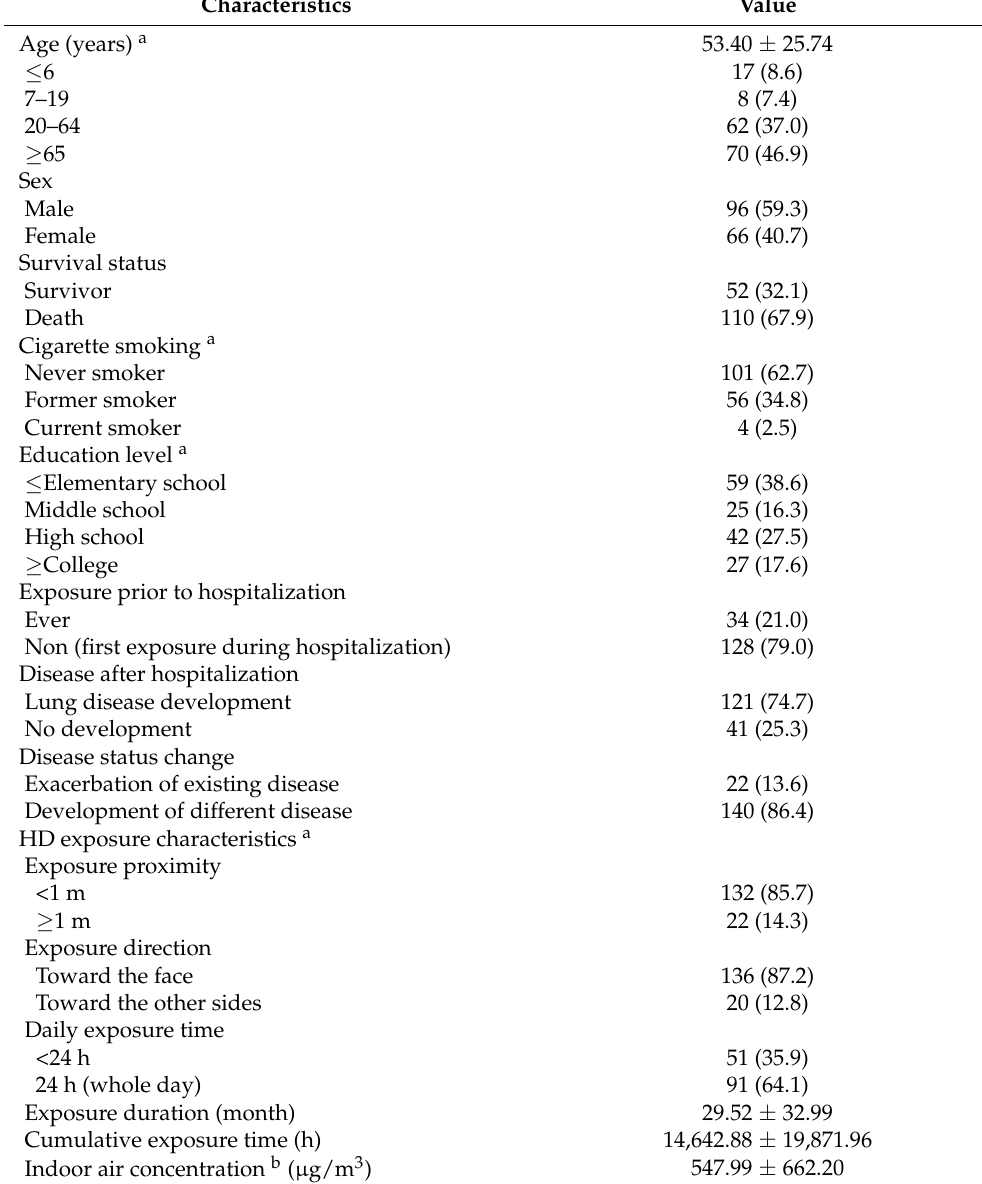
Table 1. Characteristics of participants ( n =